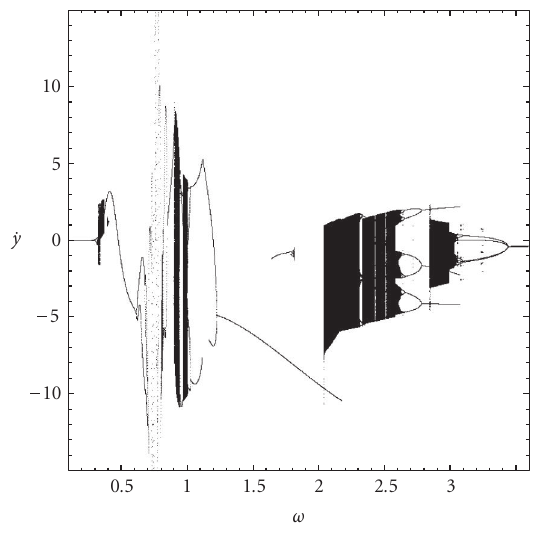
Figure 4.1. Bifurcation diagram for the e ff ective